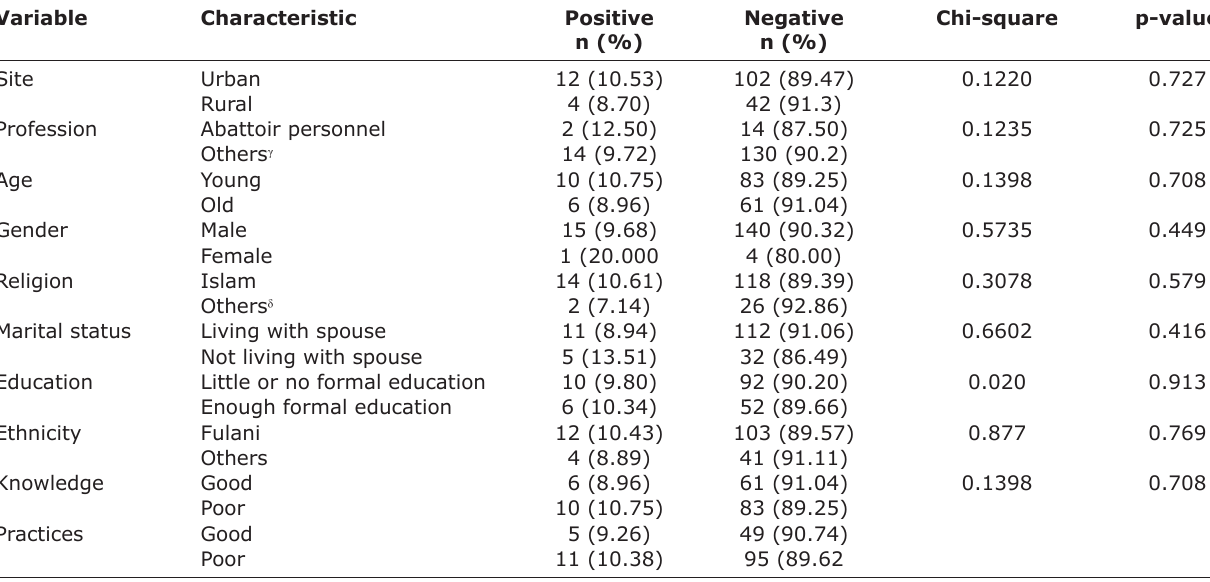
Table-1: Factors associated with seroprevalence of brucellosis as measured with the RBT among high-risk persons in Lafia, Nasarawa State.